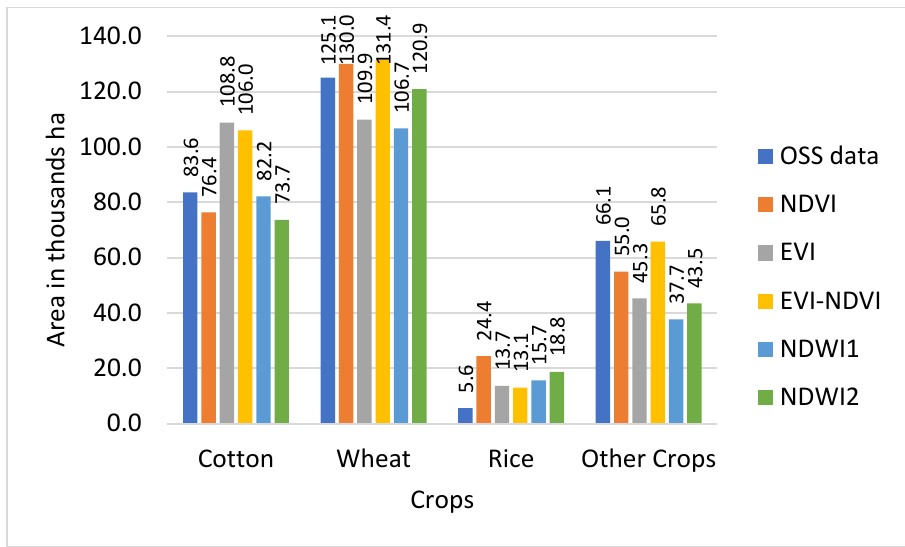
Figure 9. Comparison of classified crop types area with OSS data for RF classifier with L8 sensor.